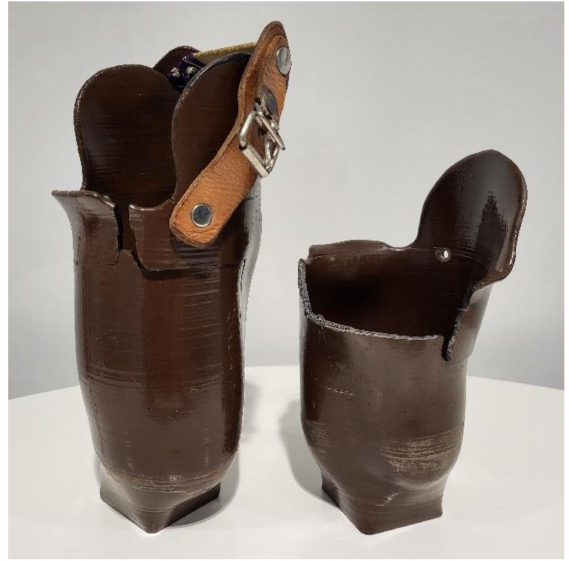
Figure 2. Left : Participant 002 indicated that his prosthetic socket was broken after an estimated time of three months. The socket was broken at the lateral side of the popliteal. Right : Participant 004 indicated at an estimated time of 6 to 7 weeks after receiving the prosthesis that the socket with 4 mm thickness was fractured at the patella